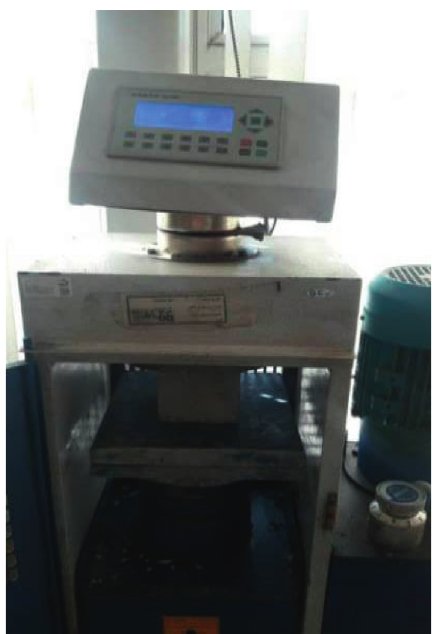
Figure 2: Hydraulic test